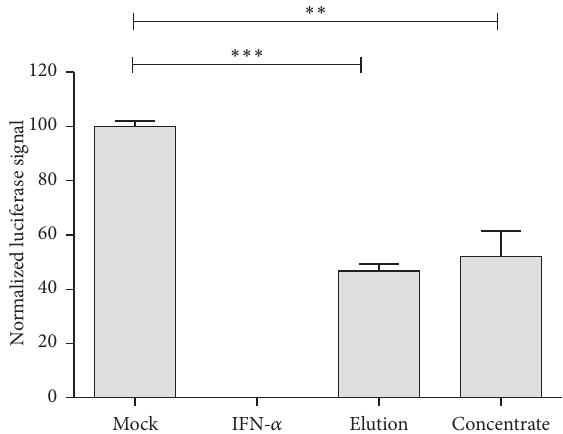
Figure 7: IFN- 𝛼 induced factors inhibit HCV replication. Huh7.5 cells were seeded in 96-well plates in triplicate 24 h prior to virus infection. HCV luciferase reporter virus was used to infect cells at an MOI of 0.1 TCID50/cell. 1000 IU/mL of IFN- 𝛼 , 10 𝜇 L of prepared “elution” or “concentrate” was added to the culture medium (total volume = 200 𝜇 L) from the beginning of inoculation until the cells were lysed 72 h later after HCV infection. Luciferase activity was determined and one of two independent experiments is displayed as mean ±